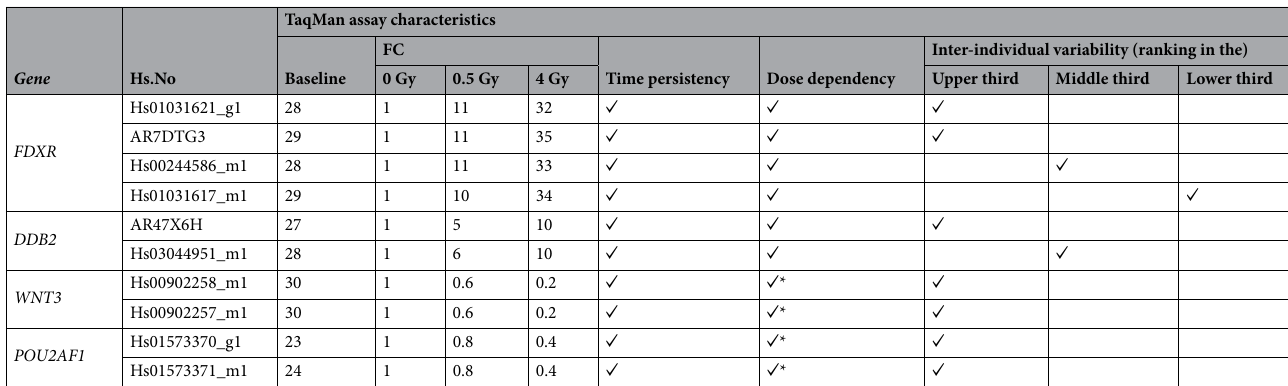
Table 1. Results overview. Displayed are the TaqMan assays per gene that were most suitable for biodosimetry purposes considering adequate baseline, the magnitude of radiation-induced differential gene expression, similar gene expression over time and inter-individual variability. Asterisks represent a dose-dependency only for 4 Gy. Assay labels starting with the two capital letters “AR” can be found after creating an account at Thermo Fisher web site, entering the “Reorder Custom Assays” section with the implemented search function in the “Custom TaqMan Assay Design Tool”. FC = fold change with the reference 0 Gy set to a FC of